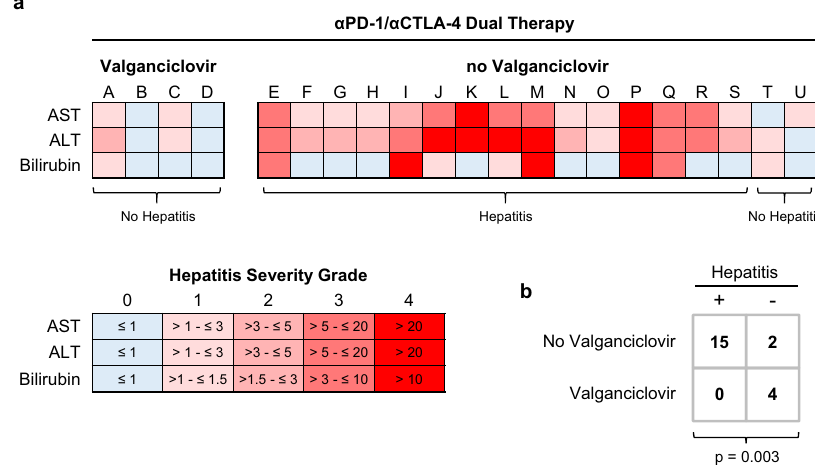
Fig. 9 Valganciclovir prophylaxis prevents α PD-1/ α CTLA-4-related hepatitis. a Heatmaps showing peak values of AST, ALT and bilirubin expressed as multiples of sex-adjusted upper limit of normal ranges. Fifteen of 17 (88.2%) patients classi fi ed as CMV IgG + CD4 + T EM ≥ 16% at baseline subsequently developed hepatitis. In contrast, 4 of 4 CMV IgG + CD4 + T EM ≥ 16% patients treated with 900 mg/day prophylactic valganciclovir remained hepatitis